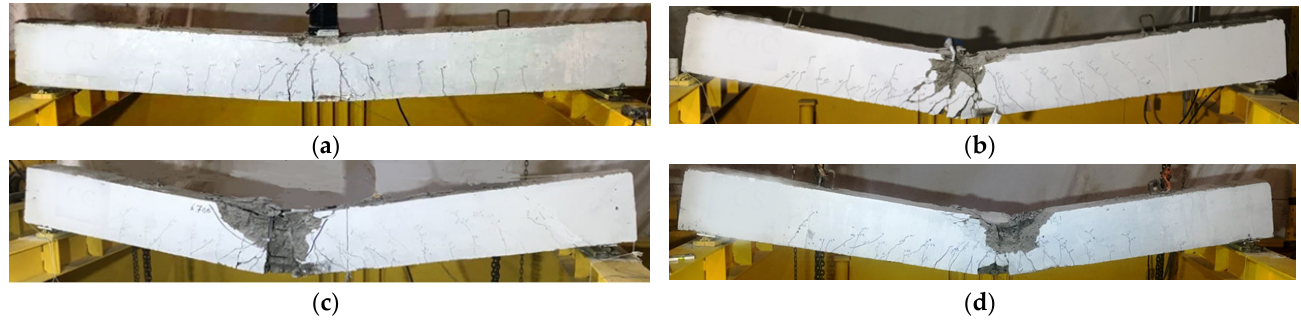
Figure 4. Modes of failure of the tested specimens under static test: ( a ) Specimen NR; ( b ) Specimen CG; ( c ) Specimen CGC; ( d ) Specimen CS.